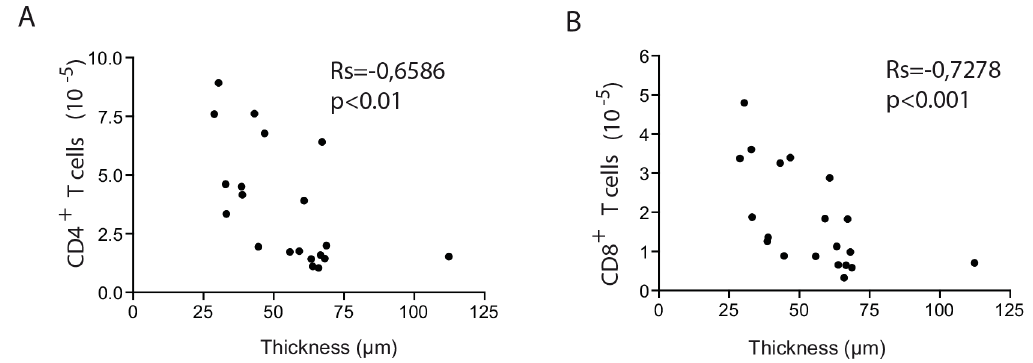
Figure 3. Paricalcitol’s enhancement of T cell numbers is inversely correlated with peritoneal thickness. The increased levels of CD4 + (A) and CD8 + (B) T cells are strongly correlated with lower peritoneal fibrosis. n $ 5 in each group. Statistical significance was determined using the Mann-